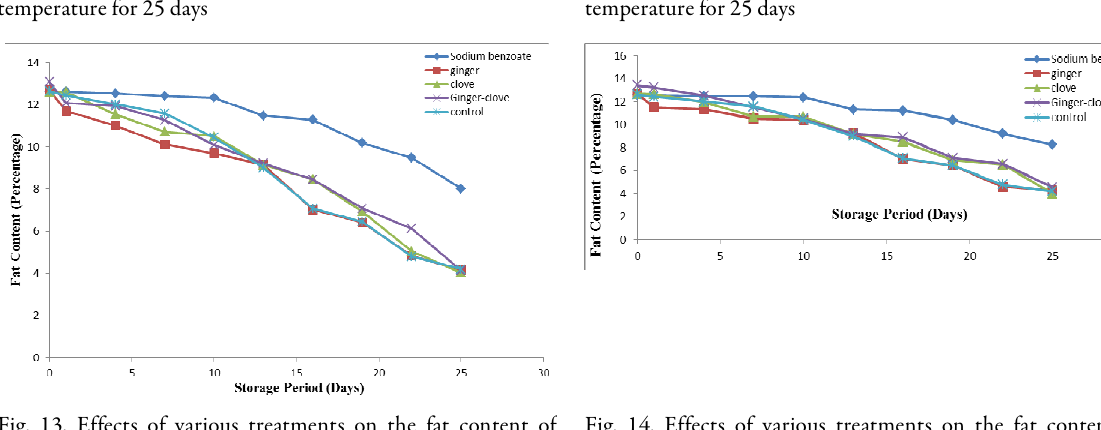
Fig. 13. Effects of various treatments on the fat content of soymilk samples at 1% concentration stored at refrigerated temperature for 25 days